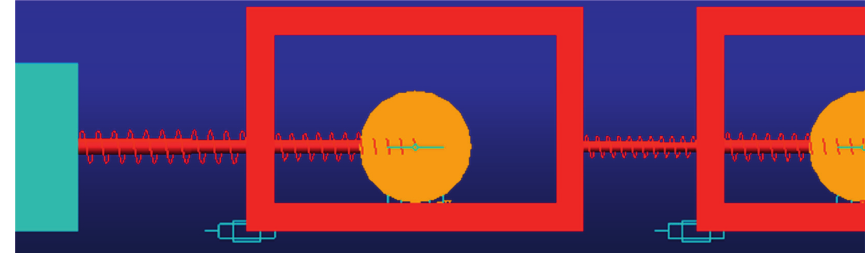
Figure 7: A schematic of a unite cell of 1DOF model-MSC-ADAMS software.